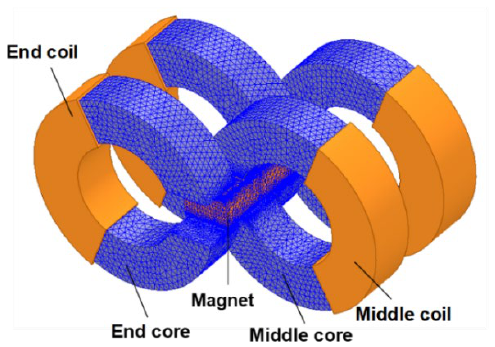
Figure 3. The FEA model of the moving magnet linear motor.